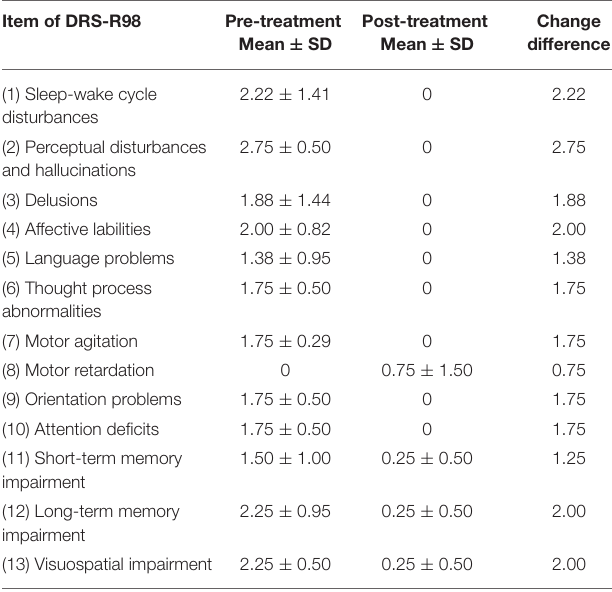
TABLE 2 | Baseline DRS-R98 scores and changes after naloxone treatment ( N = 3). Item of